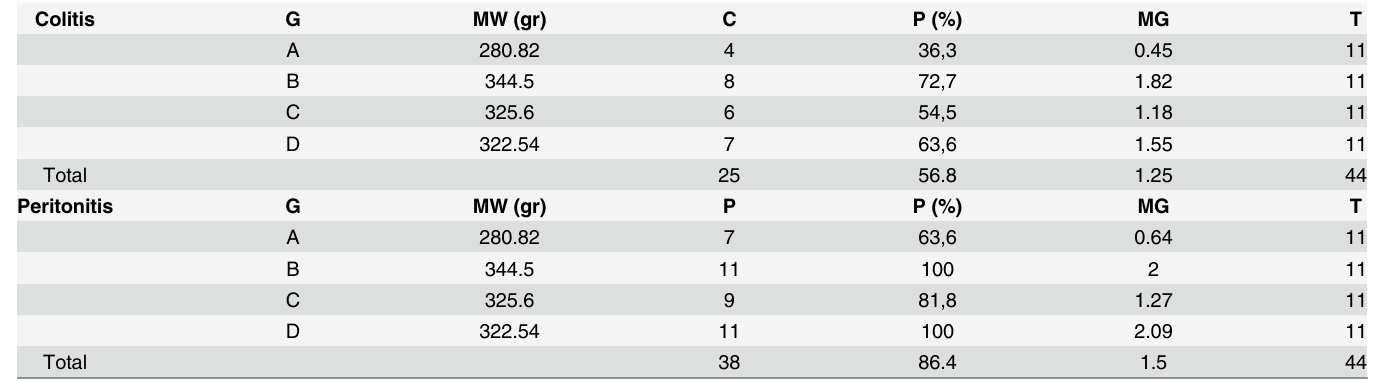
Table 2. Distribution of the grades of colitis and peritonitis among the four groups.